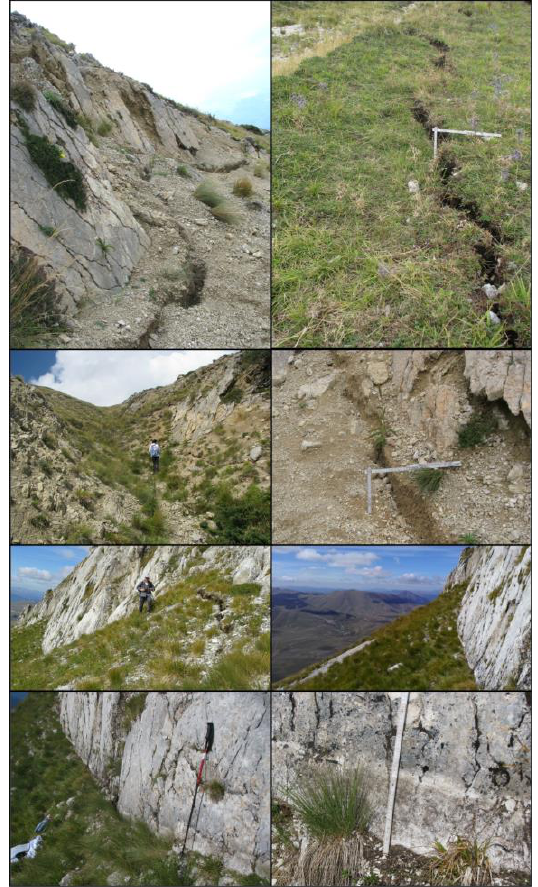
Figure 4 – Pattern of ground ruptures observed along the Monte Vettore fault. See text for